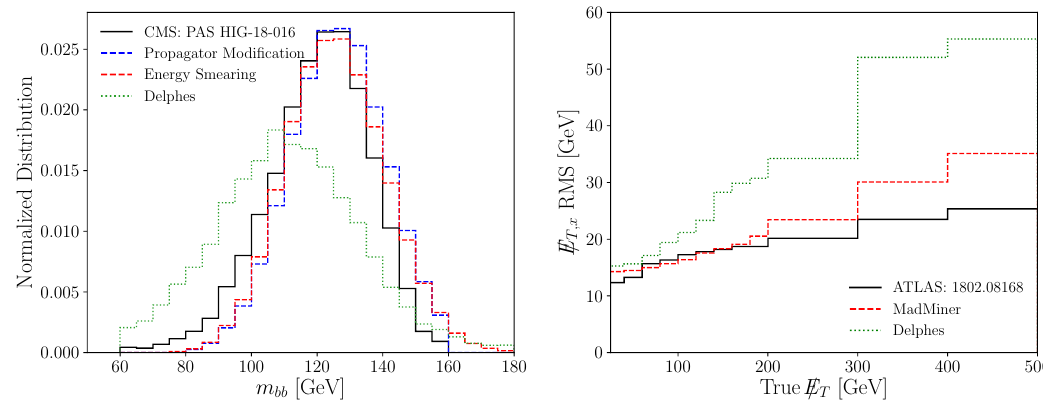
Figure 9 . Left: invariant di-jet mass m bb from Higgs decay obtained by CMS [73] (solid black), the parton level energy smearing (dashed red), the modi(cid:12)ed Higgs propagator smearing (dashed blue), and a simulation of shower and detector response with Pythia 8 and Delphes 3 (green dotted). Right: RMS of the missing transverse momentum smearing in the x-direction, =E T;x , as a function of the true missing energy =E T for the signal process obtained by ATLAS [41] (solid black), the MET smearing in MadMiner , (dashed red) and by a simulation of shower and detector response with Pythia 8 and Delphes 3 (dotted